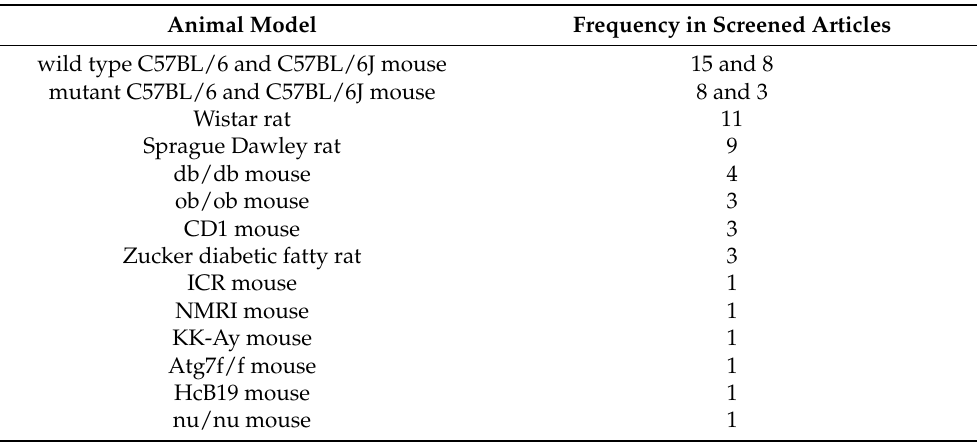
Table 5. Frequency of animal models used in screened literature ( n = 73). Institute for